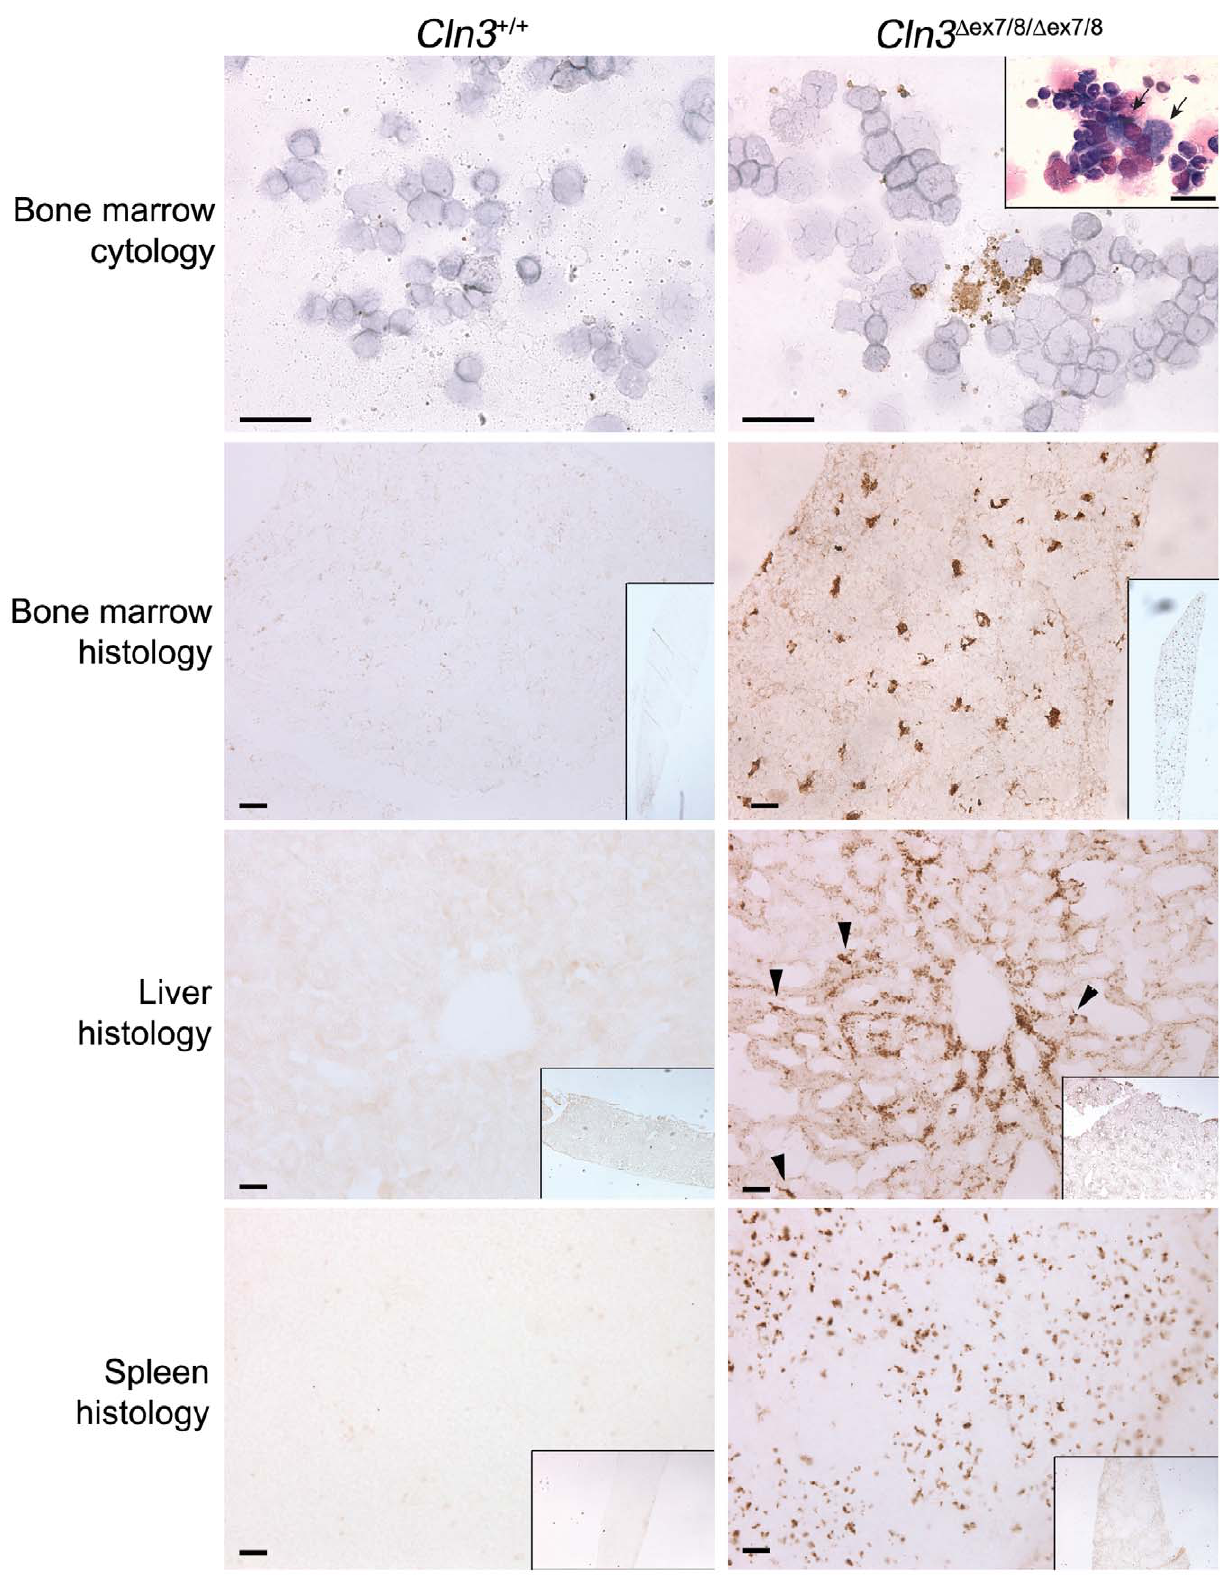
Figure 7. Subunit c immunohistochemistry of major hematopoietic tissues from 12-week-old Cln3 D ex7/8 mice. Representative images from bone marrow brush cytology, tibia cross-sections (‘Bone marrow histology’), and liver and spleen sections immunostained for subunit c are